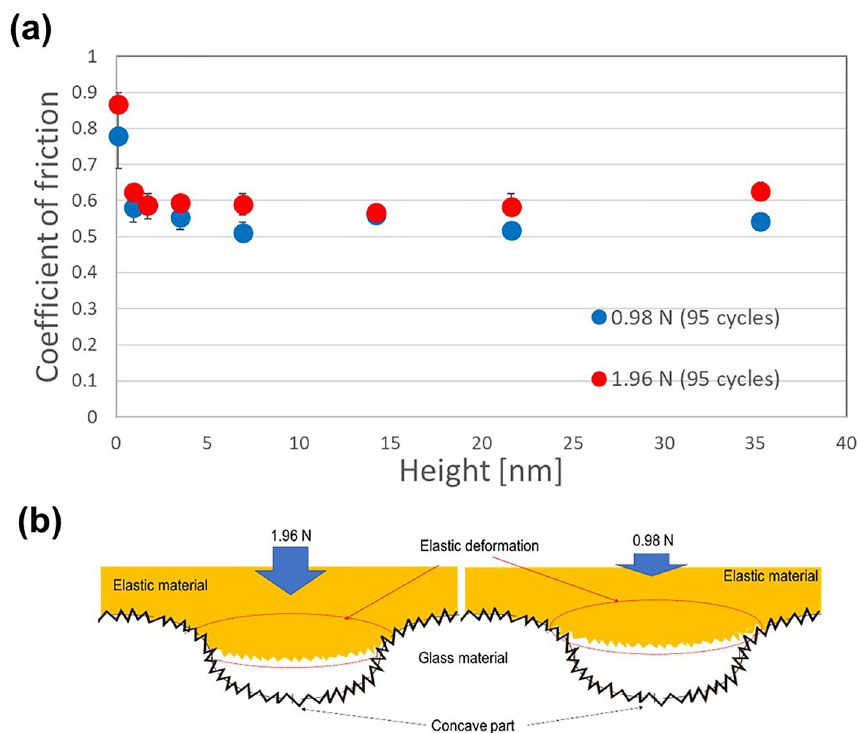
Figure 3. Difference in friction behavior in 750 μm pitches under the loads of 1.96 N and 0.98 N. ( a ) Relation between the friction coefficient and the convex-concave height in the glass surfaces for the elastomer